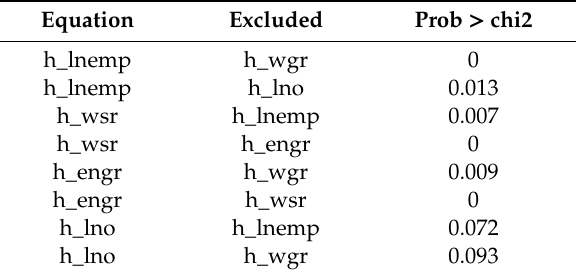
Table 6. Granger causality test results of clean